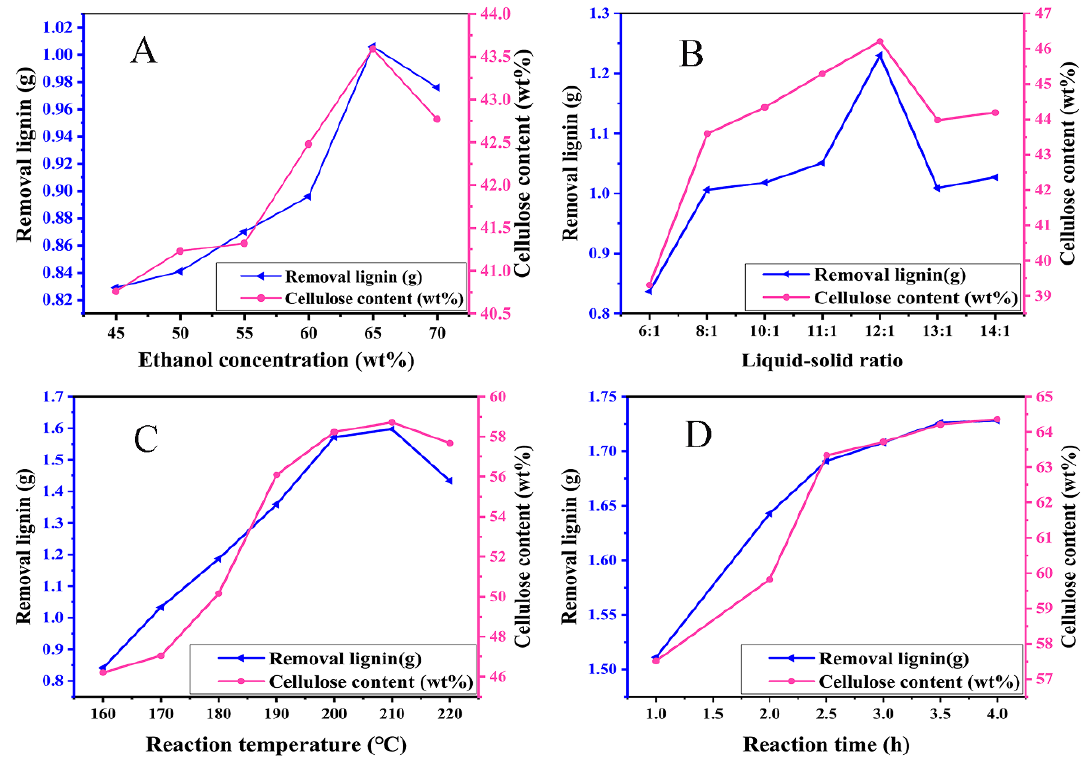
Figure 2. Optimization of the extraction conditions of RSC: ( A ) ethanol concentration, ( B ) liquid – solid ratio, ( C ) reaction temperature, ( D ) reaction time.